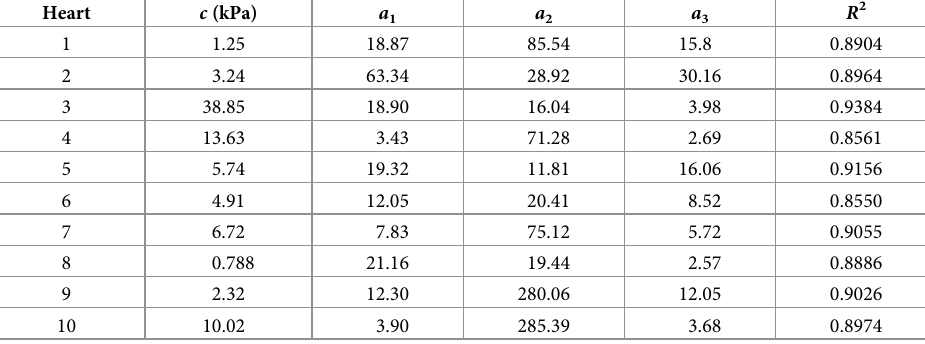
Table 5. Post-sham treatment (control group) fitting parameters for Fung-type